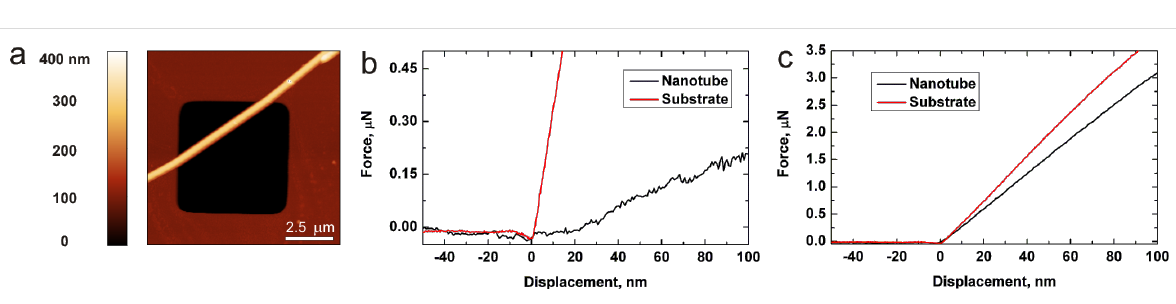
Figure 3: Three-point bending test and nanoindentation. AFM image of suspended silica NT (a); force–distance curve taken on the suspended part of the NT (b); nanoindentation force–distance curve taken on adhered part of the same NT